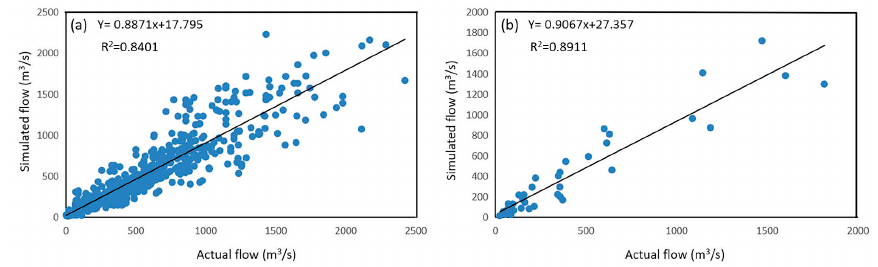
Figure 3. Comparison of periodic and validation period determination coefficients for the source region of the Yangtze River rate. ( a ) is the rate periodic volume; ( b ) is the validation period volume.